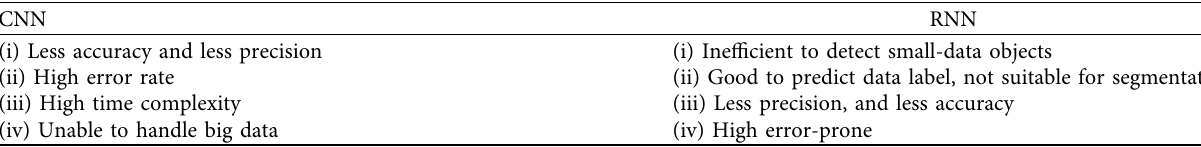
Table 2: Disadvantages of CNN and RNN techniques.